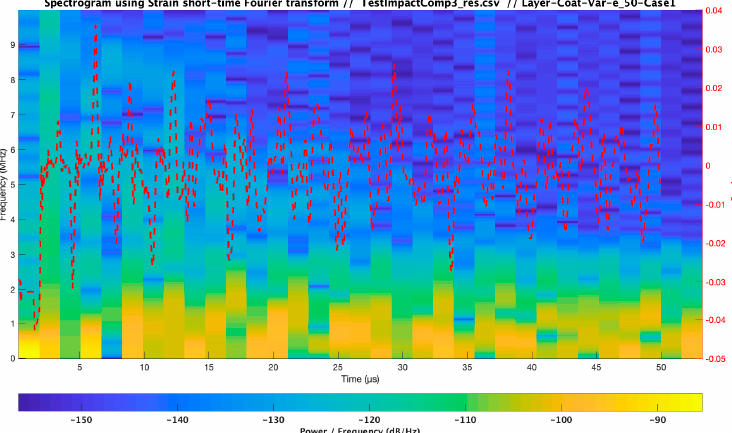
Figure 21. Spectrogram for strain evolution at the middle coating layer. Comparison for coating thickness variation respect to the reference LEP multilayer configuration (Case 1).